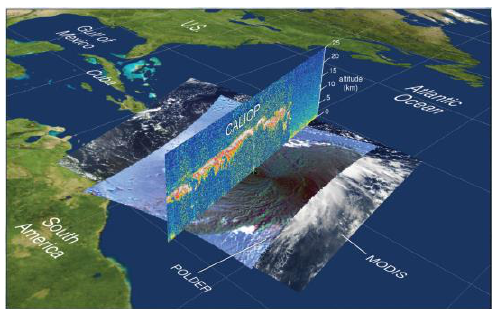
Figure 1 . Combing satellite observation to monitor PM 2.5 (Figure derived from https://atrain.nasa.gov/stories.php)